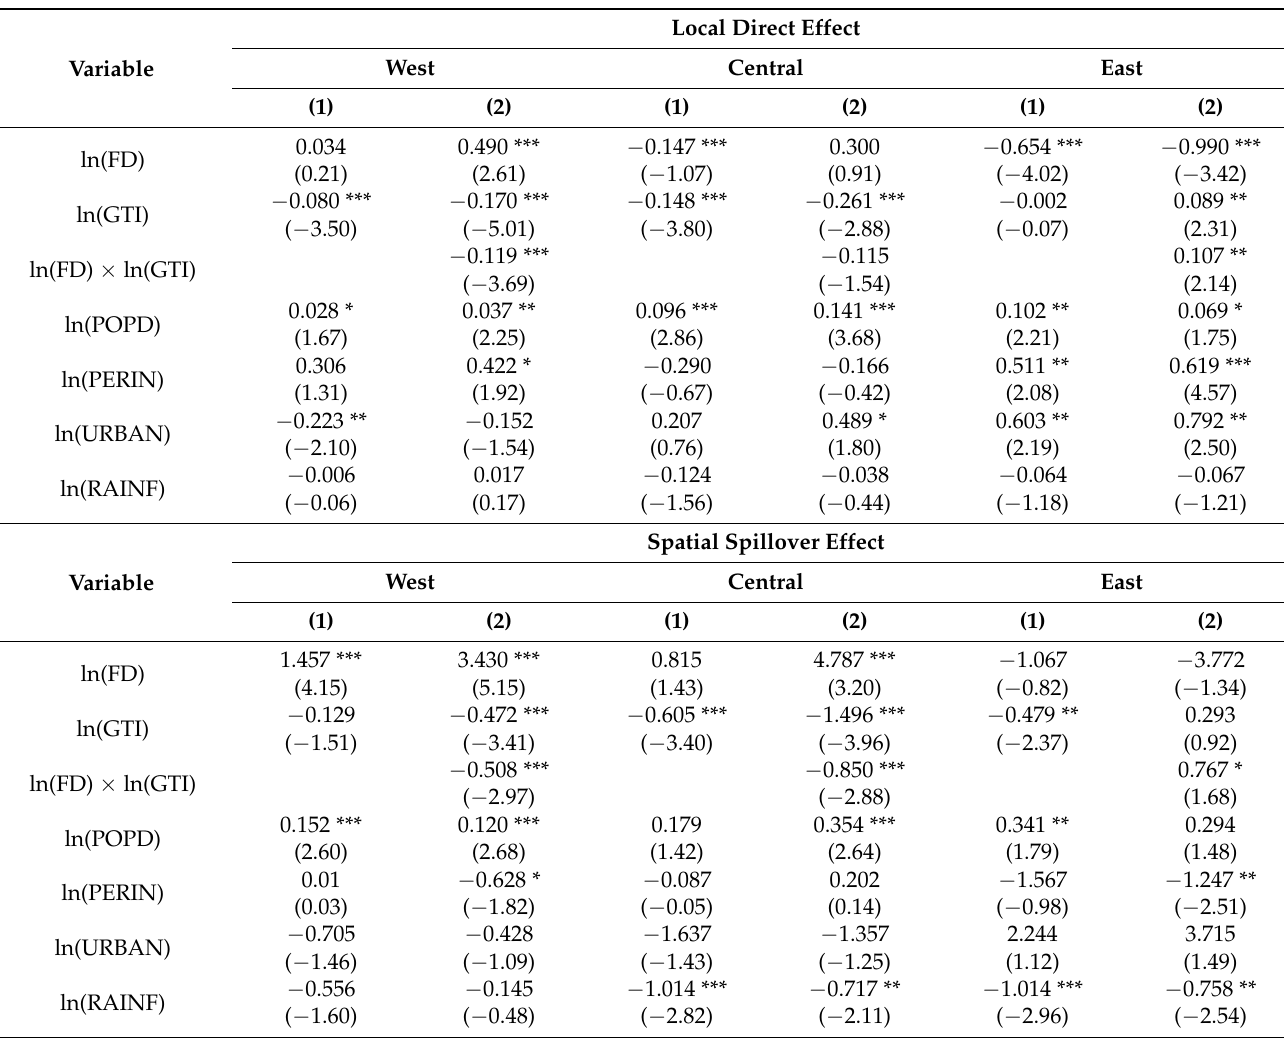
Table 8. Results of regional heterogeneity